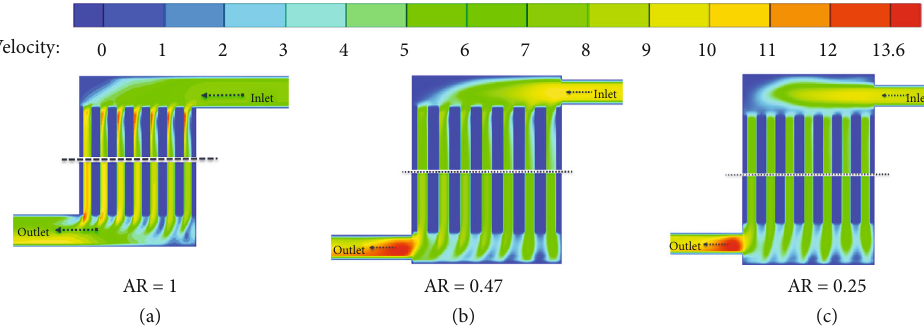
Figure 7: The velocity fi elds in the center planes with di ff erent AR values: (a) AR = 1 , (b) AR = 0 : 47 , and (c) AR = 0 : 25